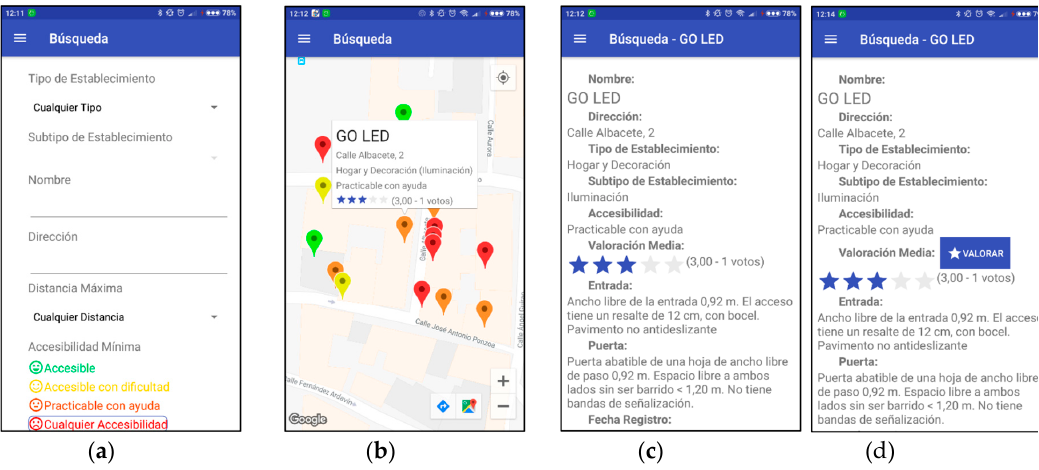
Figure 7. Different views of the app related to the search. ( a ) Search screen. ( b ) Search results after selecting a mark. ( c ) Shop details for an unregistered user. ( d ) Shop details for a registered user.